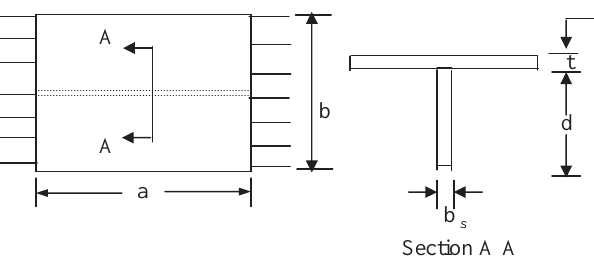
Fig. 2. Stiffened plate cross-section.